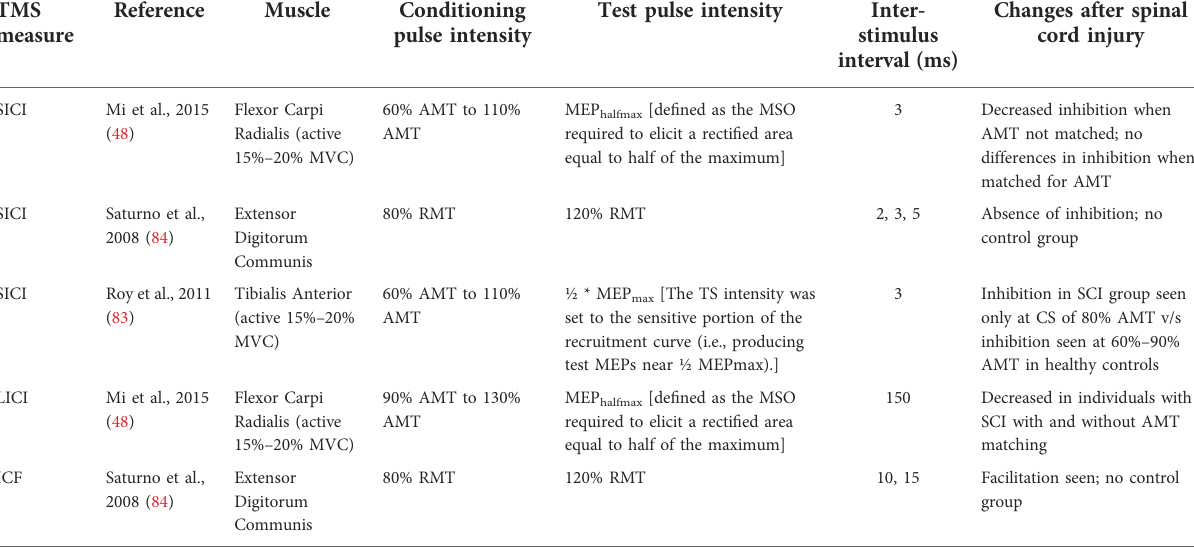
TABLE 6 Protocols for the paired-pulse TMS paradigms used in individuals with spinal cord